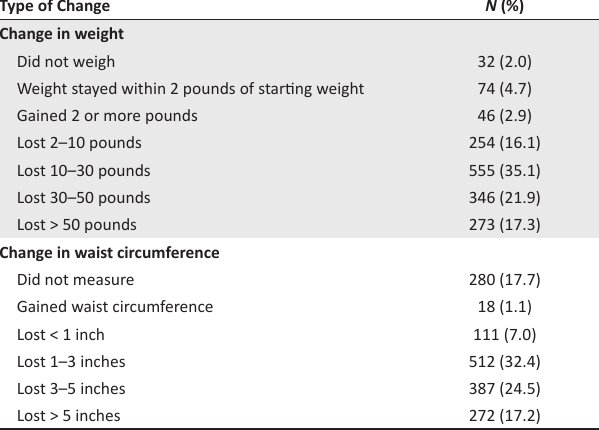
TABLE 2: Weight and waist circumference change with low-carbohydrate diet. Type of